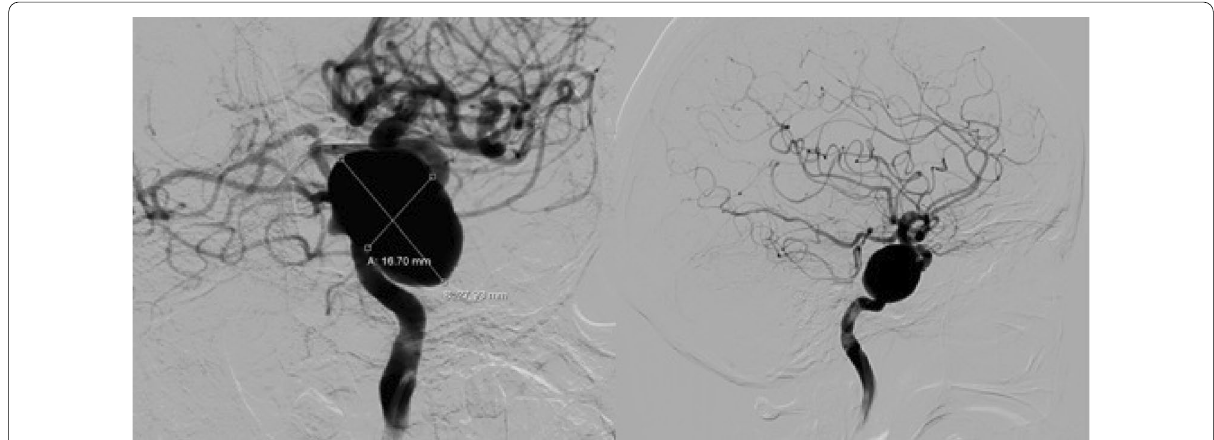
Fig. 3 Left internal carotid artery (ICA). Conventional angiogram showed fusiform dilatation of the left ICA measuring 1.7 cm